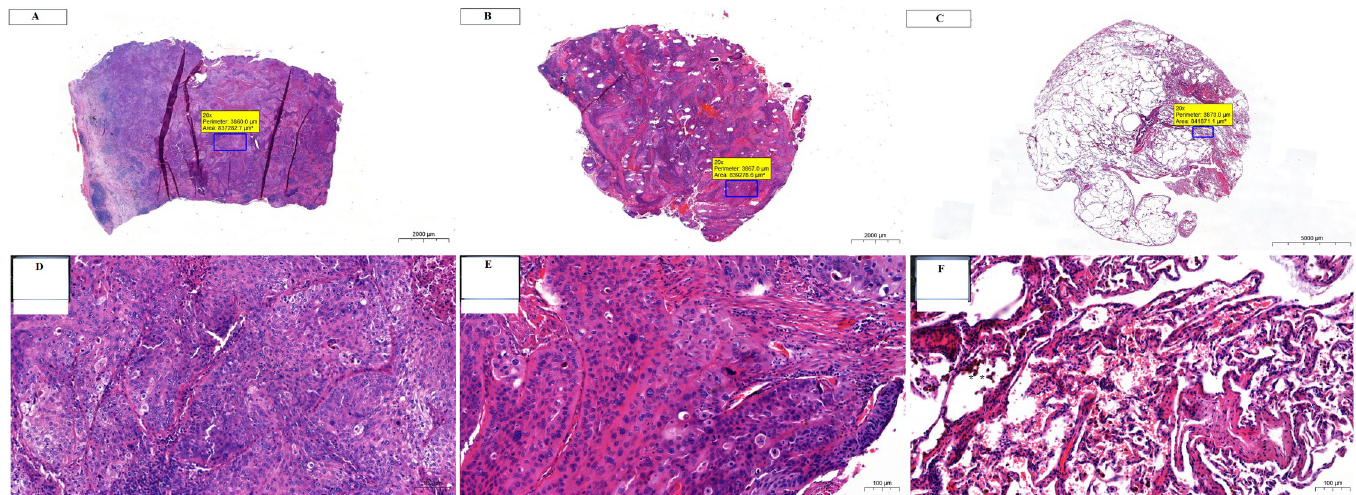
Fig 12. Microscopic features of lung squamous cell carcinoma (figures A to B and D to E) following hematoxylin and eosin staining. (A) Whole slide image of tissue collected from the margin of tumor diagnosed as pulmonary adenocarcinoma. (B) Whole slide image of tissue collected from the center of tumor diagnosed as pulmonary adenocarcinoma. (C) Whole slide image of tissue collected from non-tumor tissue referred as normal tissue. (D) Region of interest: magnification 20x. Squamous cell carcinoma, large cell, non-keratinizing, tumor grade G2 –moderately differentiated–sample collected from tumor margin. A tumor content of 80% was determined by the pathologist and can be seen in the slide scan. Tumor cells are visible in this section part of the slide. The presence of tumor necrosis was determined by a pathologist during microscopic evaluation in 2% of the tissue section area. (E) Region of interest: magnification 20x. Squamous cell carcinoma, large cell, non-keratinizing, tumor grade G2 –moderately differentiated–sample collected from tumor center. A tumor content of 80% was determined by the pathologist and can be seen in the slide scan. The presence of tumor necrosis was determined by a pathologist during microscopic evaluation in 2% of the tissue section area. (F) Region of interest: magnification 20x. Lung parenchyma–sample collected from non-tumor tissue referred as normal tissue. A small number of hemosiderin-laden macrophages can be seen in this sample and these cells are marked with